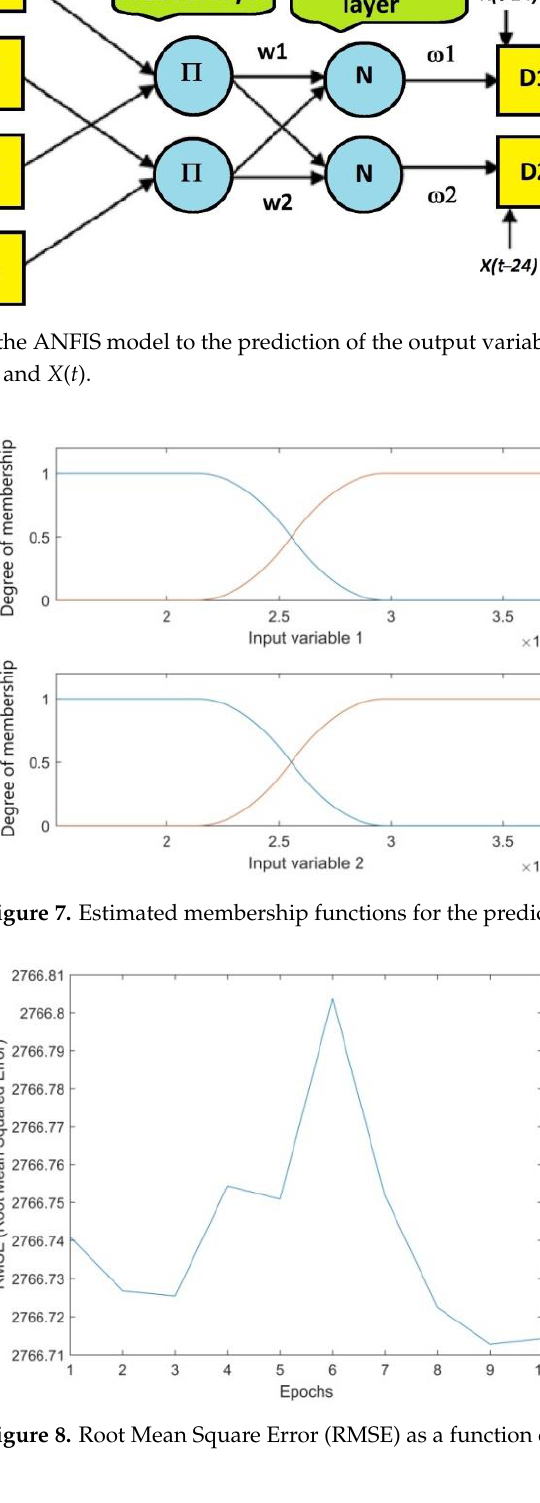
Figure 9. Comparison of Wednesday loads with the prediction. Figure 10. Absolute errors in the prediction model. The ANFIS models of load forecast were constructed for each day of the week. Table 2 presents the values of MAPE errors for ex post forecasts of loads in the case of the dis- cussed models. Some kind of estimation of the ANFIS forecasting models quality is their compari- son with the naive model results. For example, in the case of the daily load forecast con- cerning Wednesday, the naive forecast consists in adopting the relationship of loads